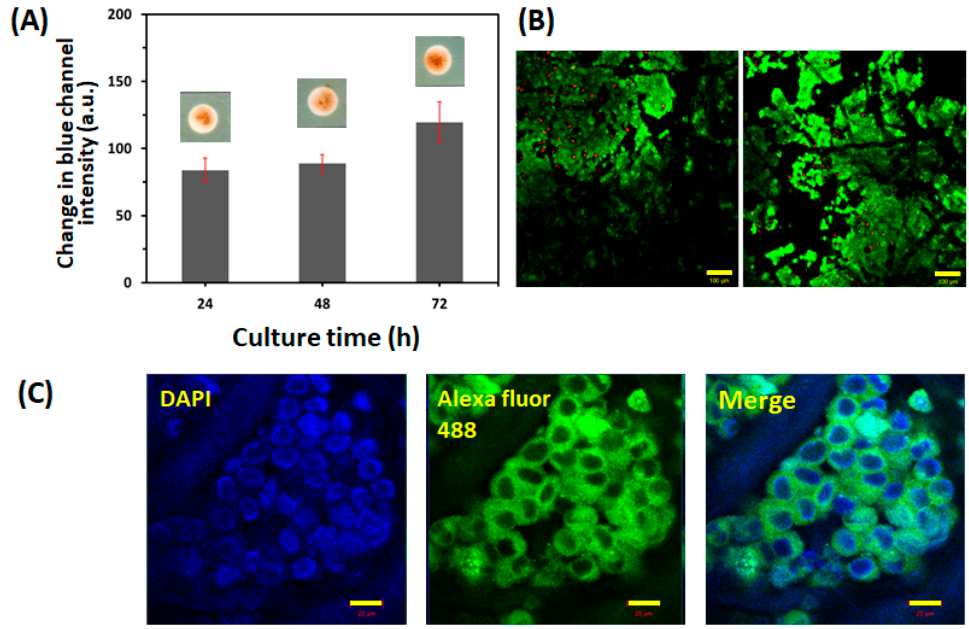
Figure 3. Evaluation of LNCaP cells cultured within the paper-integrated analytical device. ( A ) Cor- relation between cell proliferation and culture duration. Initially, 3.0 × 10 4 cells were seeded and cultured for 72 h. The proliferation of LNCaP cells was quantified at 24, 48, and 72 h using the change in blue channel intensity of WST. The evaluation was carried out in nine detection zones of three different papers ( n = 9). The error bars represent standard deviations. ( B ) Representative fluorescence images of LIVE/DEAD™ staining of LNCaP cells cultured within the paper-integrated analytical device for 72 h. The scale bar represents 100 µ m. ( C ) Representative immunofluorescence image staining for PSA (green) in LNCaP cells after 72 h of culture within the paper-integrated analytical device. The scale bar represents 20 µ